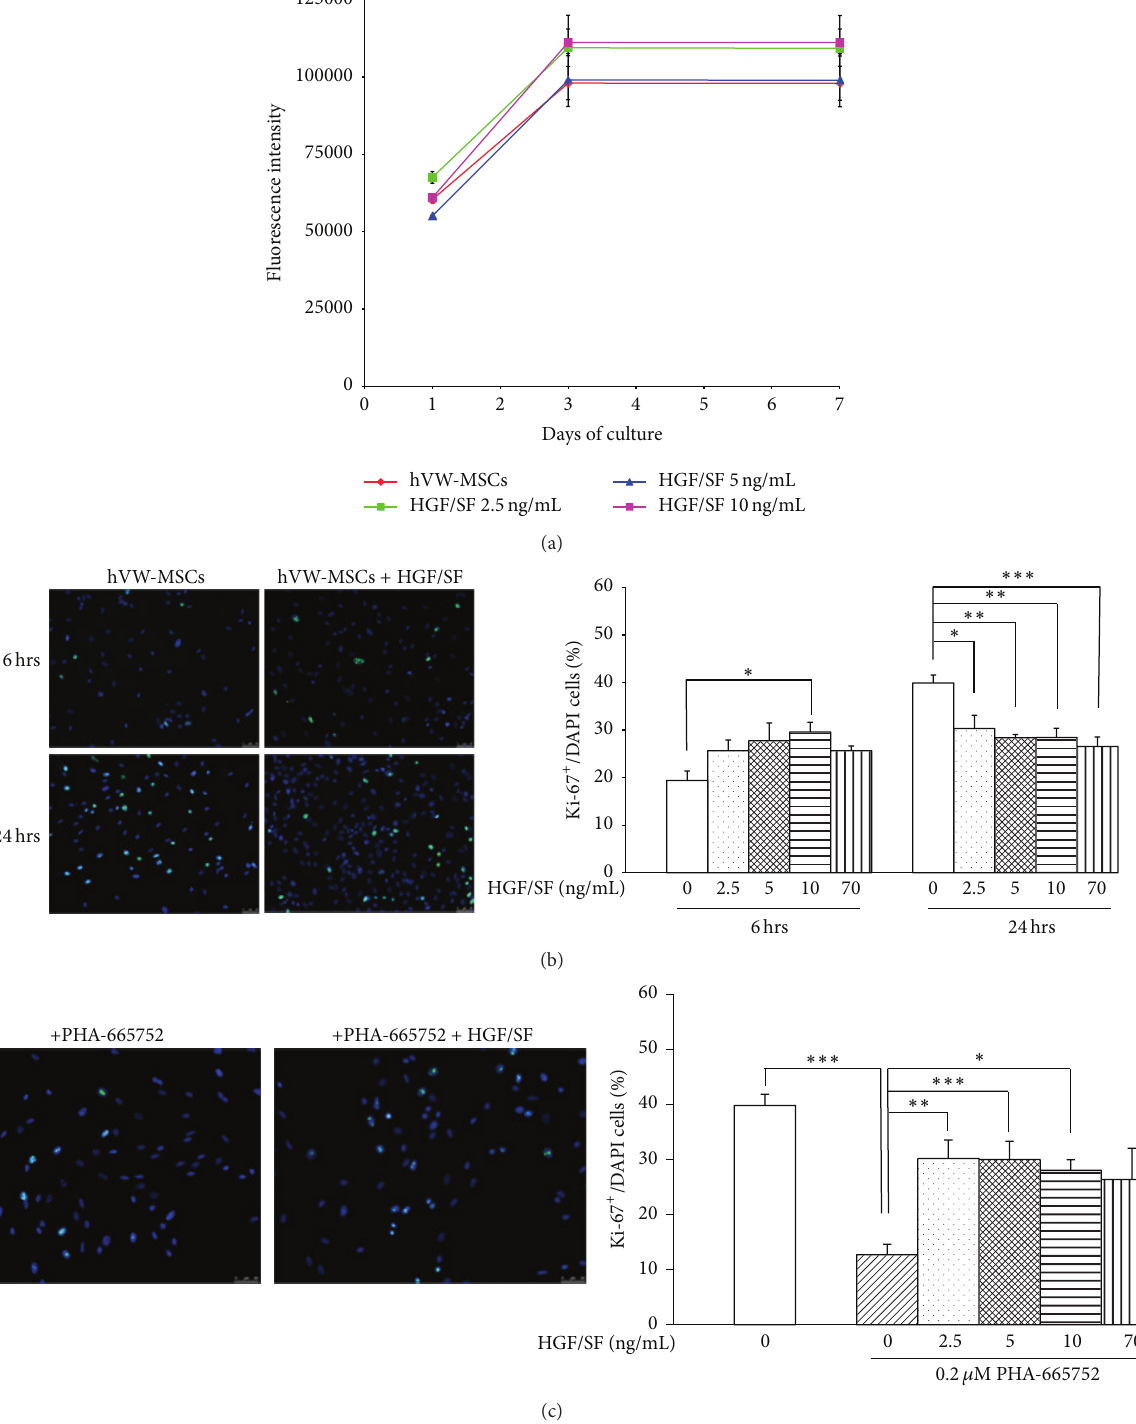
Figure 2: Proliferative effect of HGF/SF on hVW-MSCs. (a) In vitro proliferation of hVW-MSCs exposed to HGF/SF assessed by Alamar Blue fluorescence assay up to 7 days. From day 1 to day 3, the fluorescence intensity was increased in HGF/SF-treated hVW-MSCs including untreated cells (red) while no difference was seen between hVW-MSCs stimulated by HGF/SF and untreated cells at 3 and 7 days. (b) Representative images of cycling cells expressing Ki-67 protein after 6 and 24 hrs of incubation with HGF/SF, compared to controls (hVW- MSCs). Ki-67 positive cells (green) and DAPI (nuclei in blue). After 6hrs, the HGF/SF stimulation induced a slight increase of Ki-67 positive hVW-MSCspercentageontotalDAPIcells;after24 hrsofHGF/SFexposure,thepercentageofKi-67positivecellsisapproximatelyreducedof the 15% in all the experimental conditions. Scale bars = 50 𝜇 m. (c) Images and quantitative analysis of hVW-MSCs cultured with PHA-665752 and then exposed to HGF/SF. c-Met inhibitor before HGF/SF incubation revealed almost similar Ki-67 percentage reduced in comparison to control cells. Scale bars = 50 𝜇 m. (b)-(c) ∗ , ∗∗ , ∗∗∗ 𝑝 value < 0.05, and one-way ANOVA test followed by Bonferroni